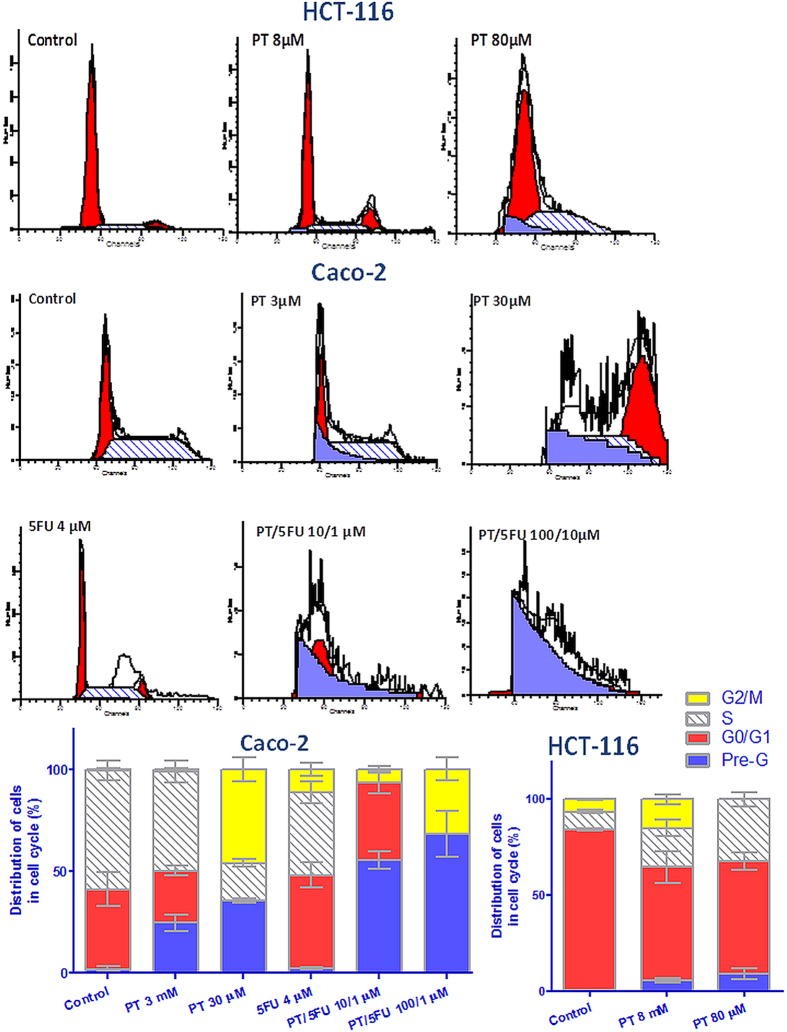
Effect of PT on DNA-ploidy flow cytometric analysis of Caco-2 and HCT-116 cells.The cells were treated with PT IC50 for 48 h. the experiment was done in triplicates. Data are means ± SD (n = 3).